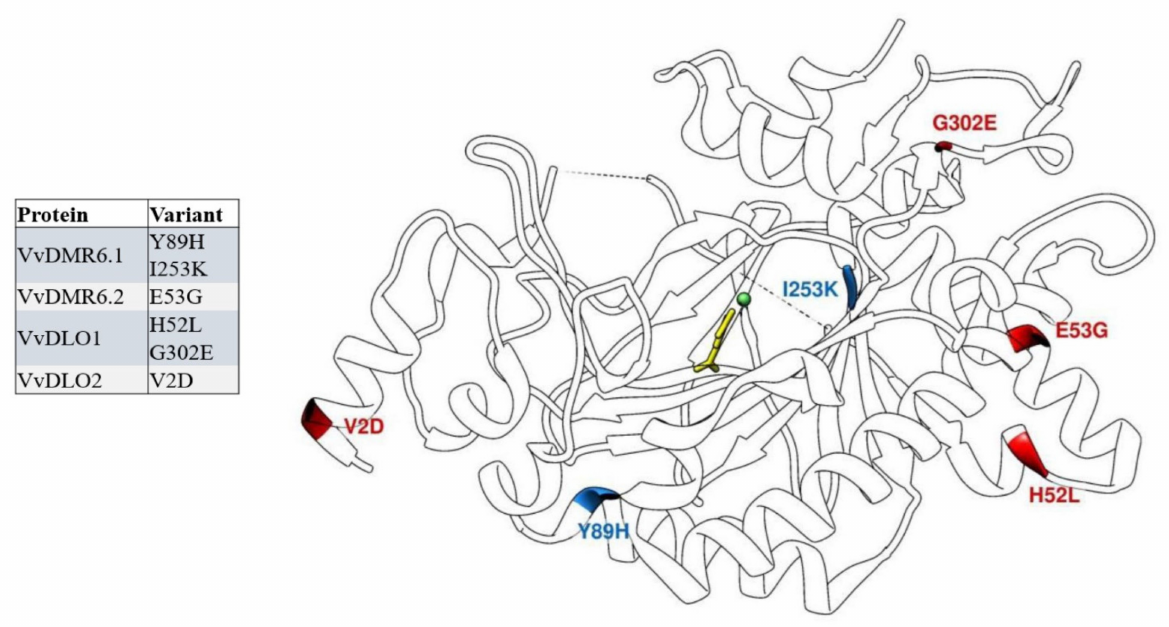
Figure 3. Protein structure model with detected impacting variants. In blue are residues located inside the protein while in red are those more exposed on the